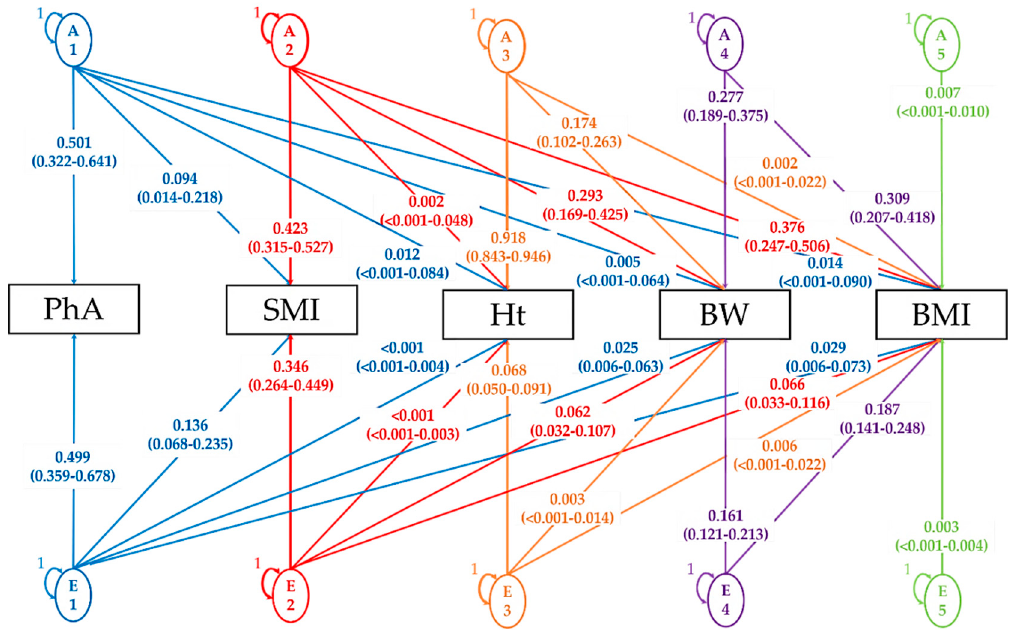
Figure 4. Cholesky decomposition path diagram among anthropometric measurements and phase angle for the AE model. Standardized path coefficients are presented. Numbers in parentheses are 95% confidence intervals of estimates. (A1–A5) additive genetic factor; (E1–5) non-shared environmental factor; PhA: Phase angle; SMI: Skeletal muscle mass index; Ht: Height; BW: Body weight; BMI: Body mass index.